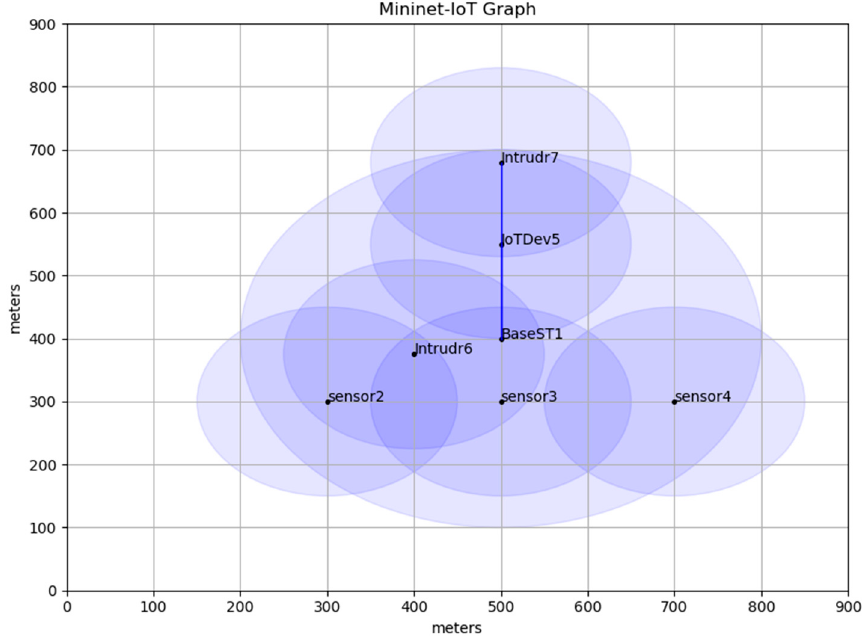
Figure 6. IoT emulation topology. Table 1. Emulation Configuration Parameters.